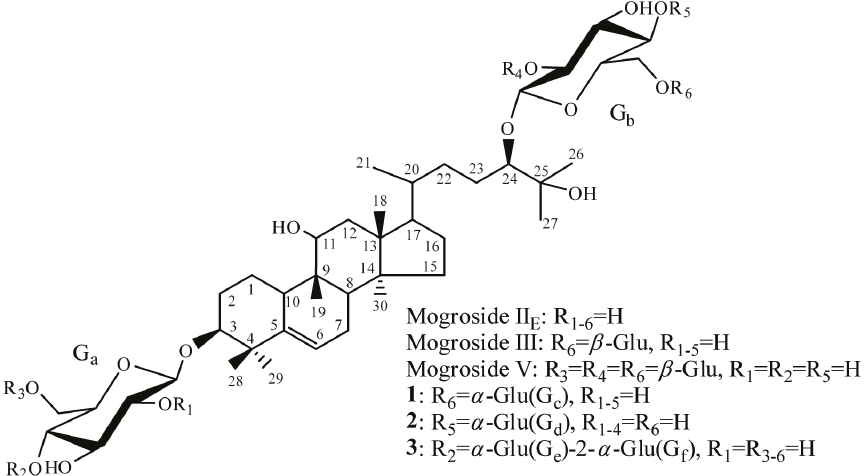
Figure 5. Structure of compounds 1 – 3 and other mentioned natural